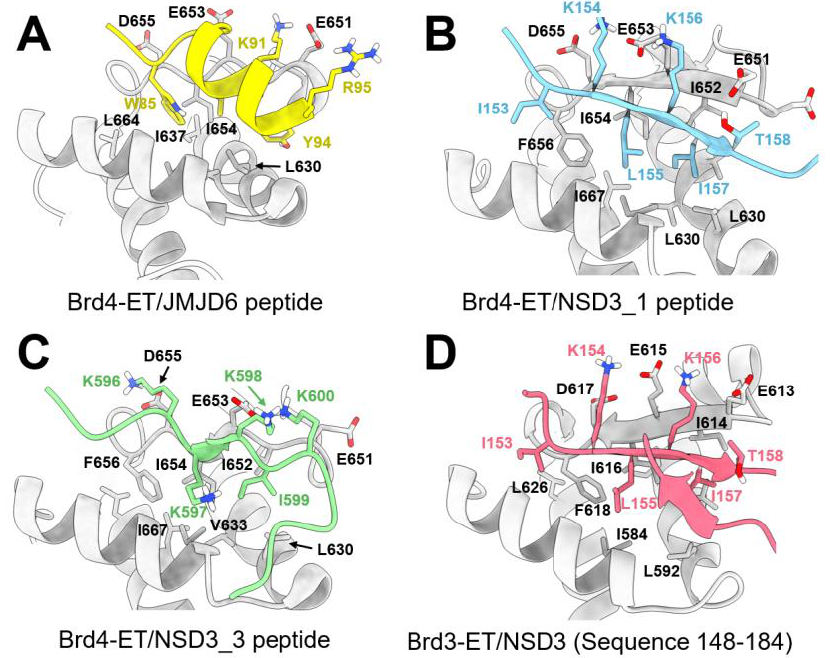
Figure 10. The scheme of the Brd3- or Brd4-ET domain interacting with NSD3 (blue, green, and pink) and JMJD6 (yellow) peptides. Interacting residues on ET are indicated in black, and interacting residues on corresponding peptides are colored as indicated. ET domains are rotated to present the best angle to see the interacting residues. The PDB codes of associated structures are ( A ) 6BNH, ( B ) 2NCZ, ( C ) 2ND1, and ( D ) 7JYN.